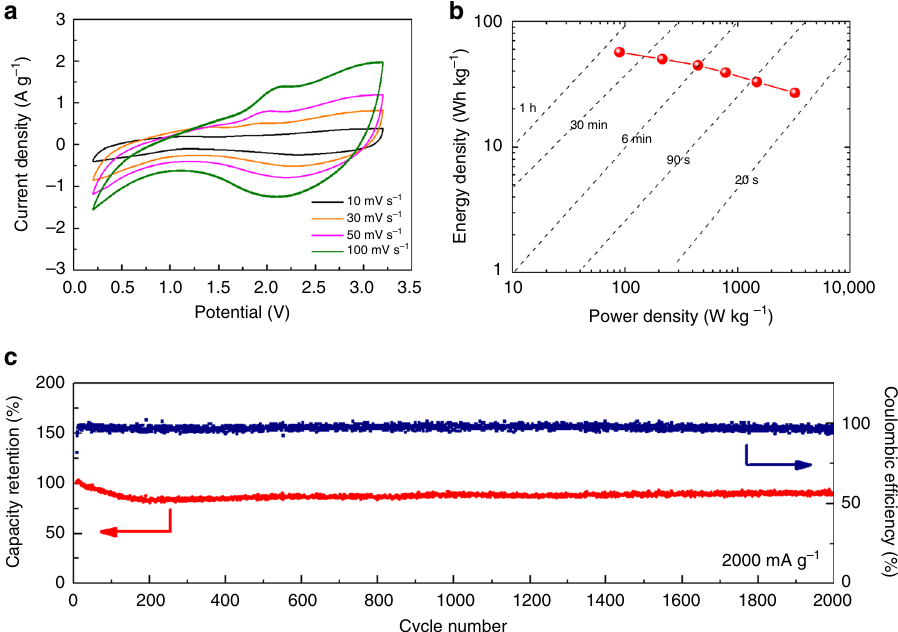
Fig. 5 Electrochemical performance of hybrid supercapacitor using an activated carbon (AC) and hydrated nanocomposite (HN) composite. a , CV curves in various scan rates from 10 to 100 mV s − 1 ; b , Ragone plots of power density vs. energy density, based on the total mass of active materials in both electrodes; c , Cycle stability and Coulombic ef fi ciency at a current density of 2000 mA g −